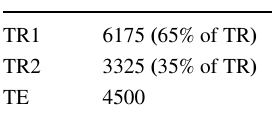
Table 1 Summary of the